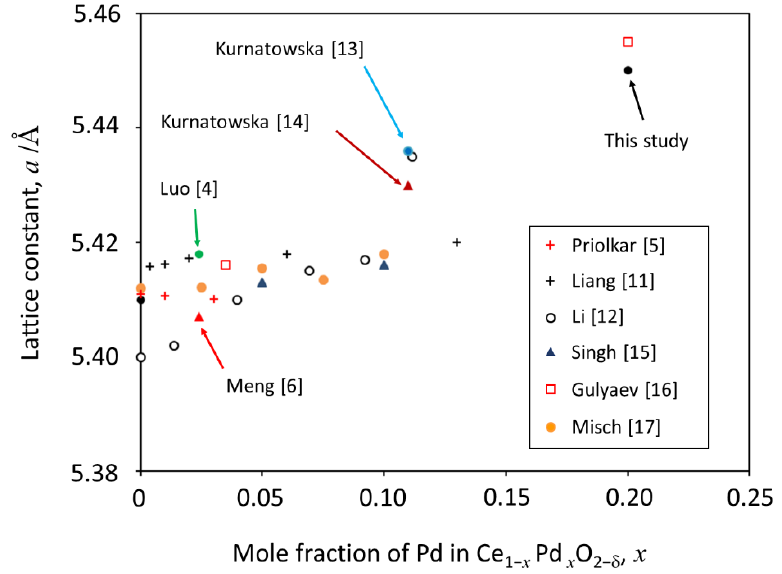
Figure 2. Composition dependences of lattice constants of Pd-substituted CeO 2 reported in the literature [4–6,11–17] and obtained in this study.